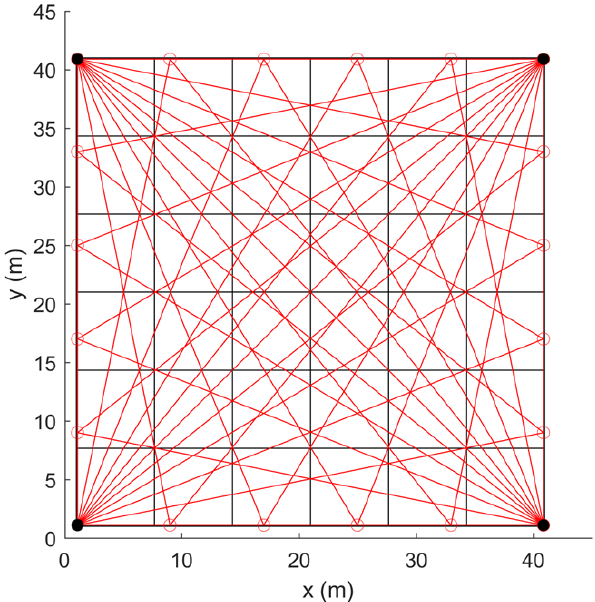
Figure 1. The beam configuration and grid division. The field was divided into 6 × 6 grid pixels. There were four open-path TDL ana- lyzers located at the four corners. A total of 20 retroreflectors were distributed on the edges of the